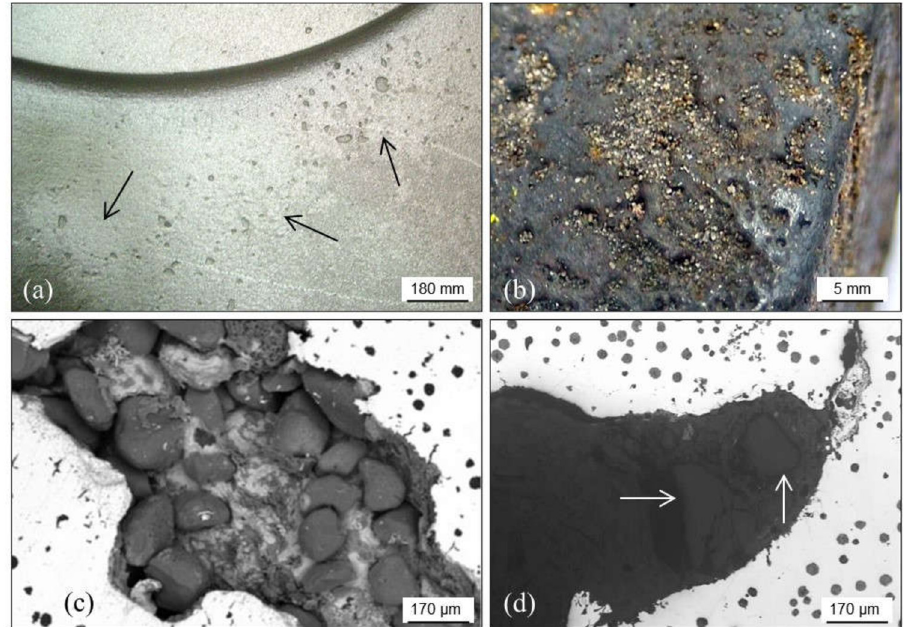
Figure 36. Sand inclusions found ( a ) in a heavy-section ductile iron casting and ( b ) in a grey iron casting produced in a dry green sand mold. Images ( c , d ) show micrographs of sand inclusions in ductile iron